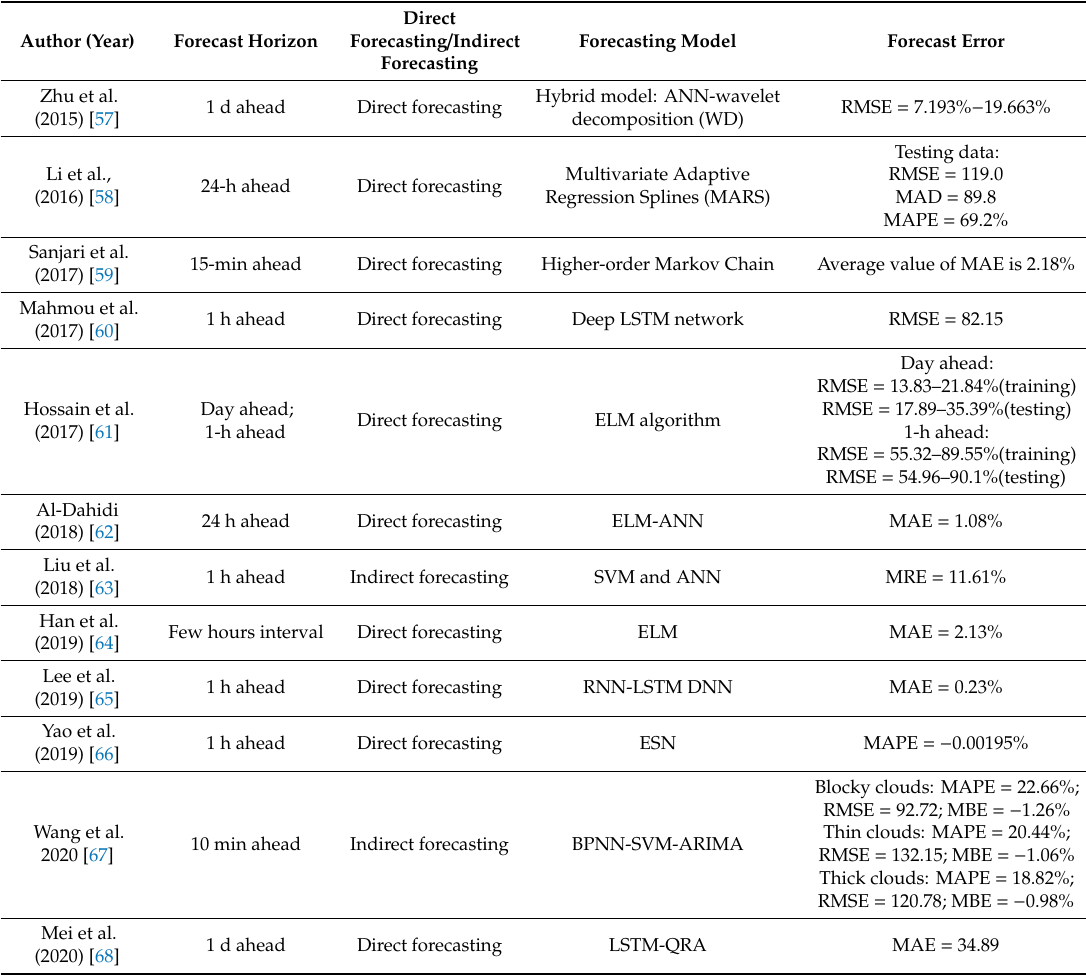
Table 3. Recent papers on PV power